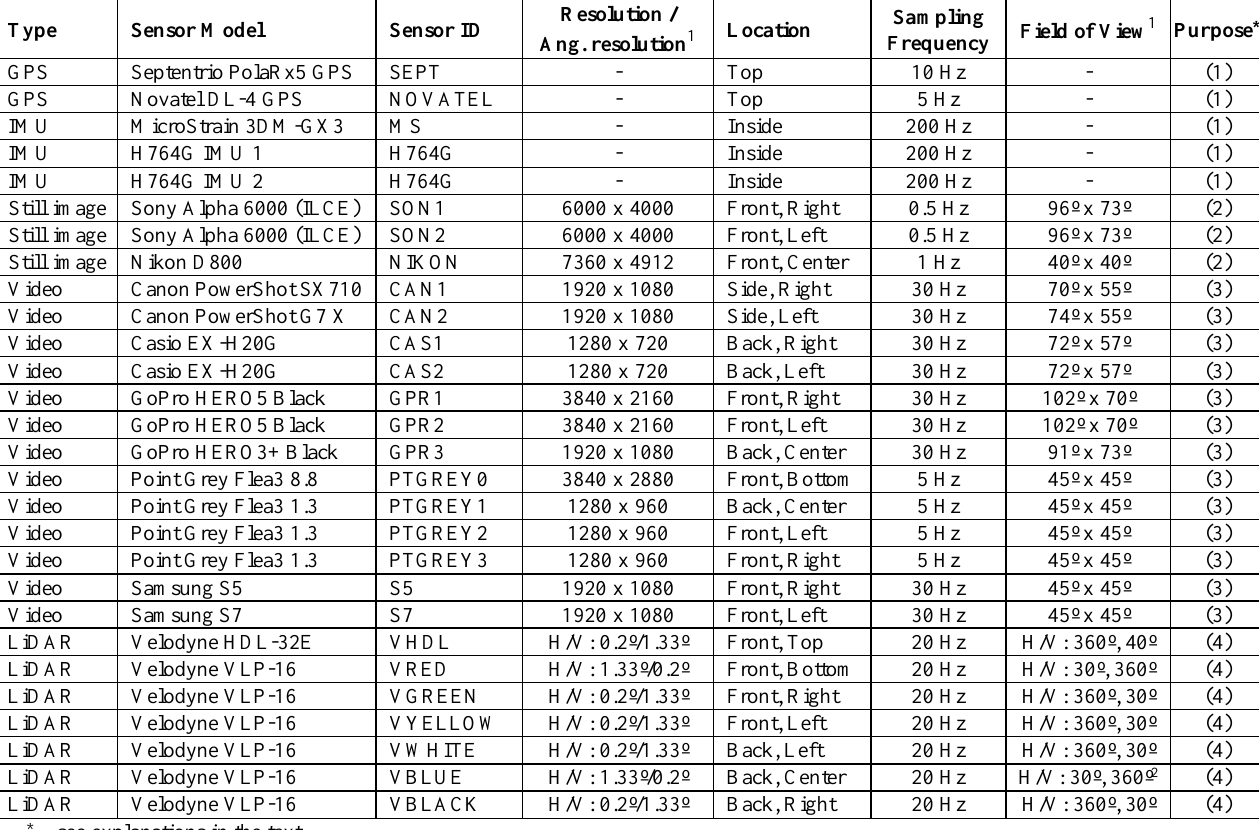
Table 1. Overview of the sensors; see explanation in the text.